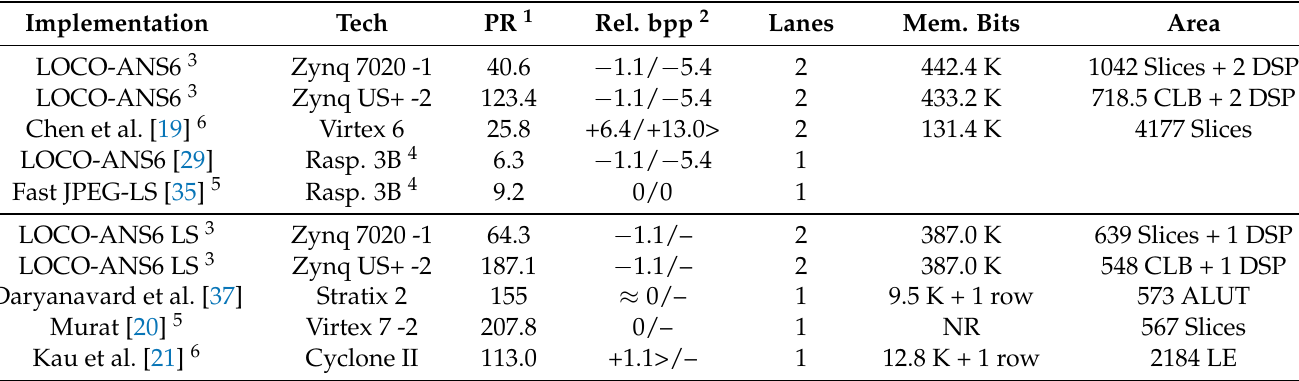
Table 4. Comparison with other codec